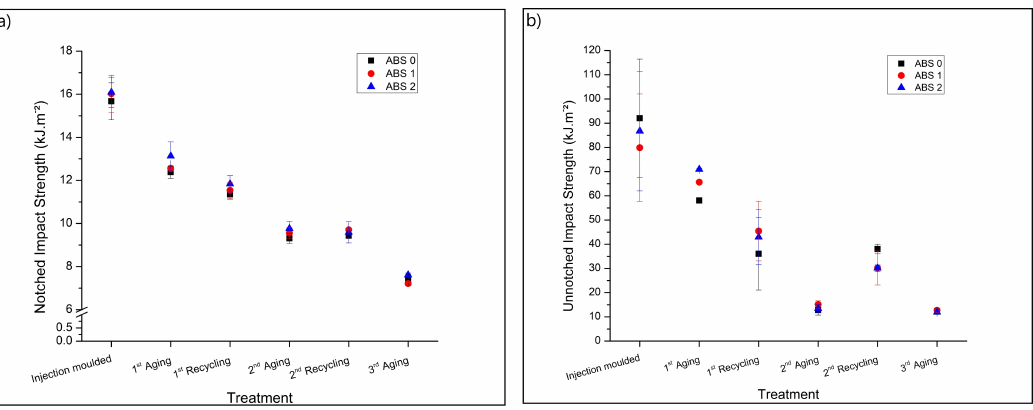
Figure 4. Impact strength of the sample types in Table 1. ( a ) Notched, and ( b ) Unnotched; testing procedure as in Figure 1.